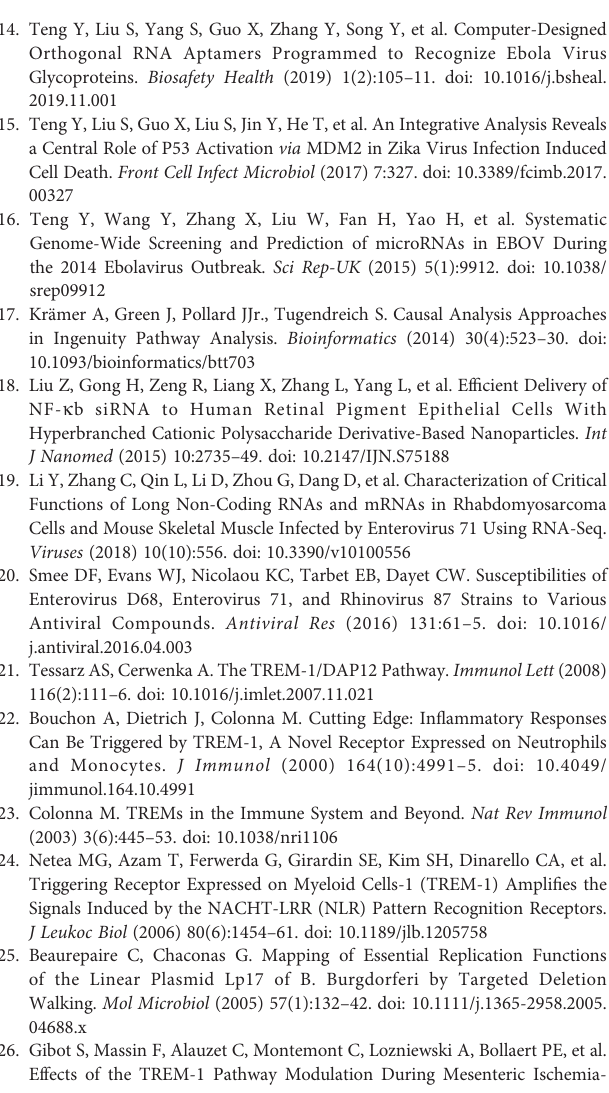
Supplementary Figure 2 | EV-D68 infection upregulates TREM-1 mRNA abundance in A549 and 2BS cells. (A, B) EV-D68-infected A549 and 2BS cells were collectedat24hpi(MOI=0.05,0.1,0.5,1),andTREM-1mRNAlevelsweremeasured by RT-PCR. The GAPDH gene served as an internal control, and relative gene expression (fold change) levels of each gene were calculated using the comparative 2 - DD CT method. Values are means ± SD. * p < 0.05, ** p < 0.01, *** p < 0.001. Supplementary Table 1 | Primer sequences used for RT-PCR. Supplementary Table 2 | Phosphorylation levels of the candidate signals downstream of TREM-1. Supplementary Data Sheet 1 | Gene expression levels of mock and EV-D68- infected RD cells at 6 hpi, 12 hpi, 24 hpi. Supplementary Data Sheet 2 | DEGs list at 6 hpi. Supplementary Data Sheet 3 | DEGs list at 12 hpi. Supplementary Data Sheet 4 | DEGs list at 24